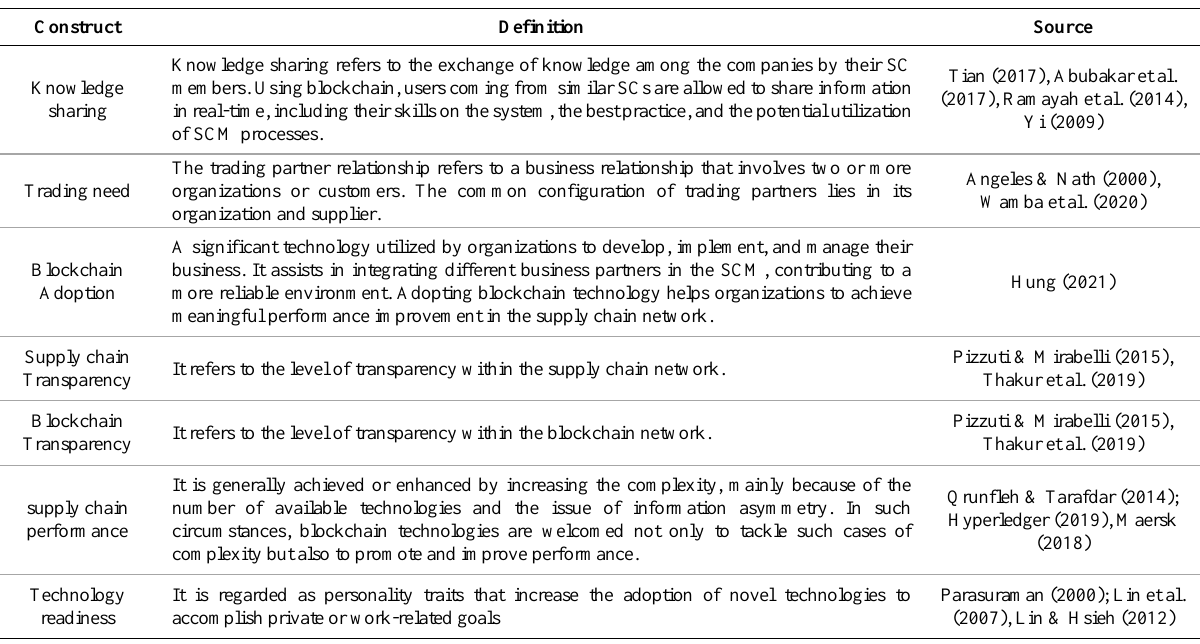
Table 1. Operational